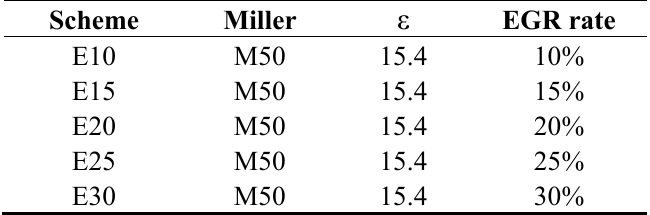
Table 6. High ε Miller cycle with EGR (exhaust gas